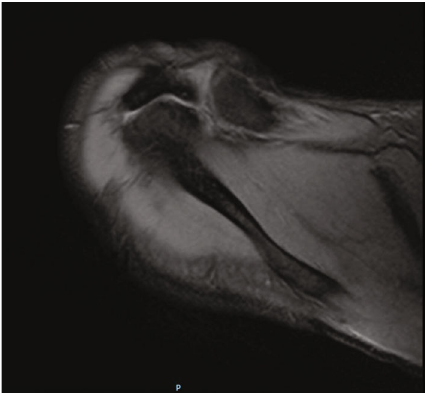
Figure 1: T2-weighted axial magnetic resonance image of meso- type Os acromiale.